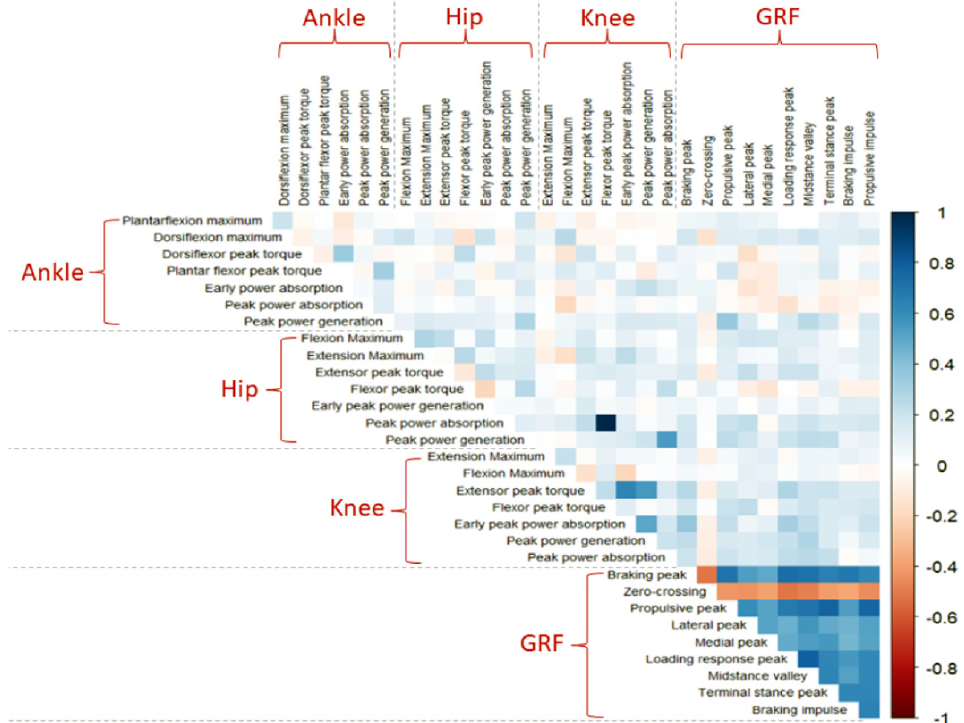
Figure 4. A correlation study of all numeric gait features regardless of PAD status (healthy controls or patients with PAD). The color line indicates the correlation coefficient between features from “Dark Red: − 1” to “Navy: 1”. A correlation coefficient of “ − 1” between two variables implies a perfect negative relationship, and a correlation coefficient of “1” between two variables implies a perfect positive relationship. If the correlation between two variables is 0, there is no linear relationship.